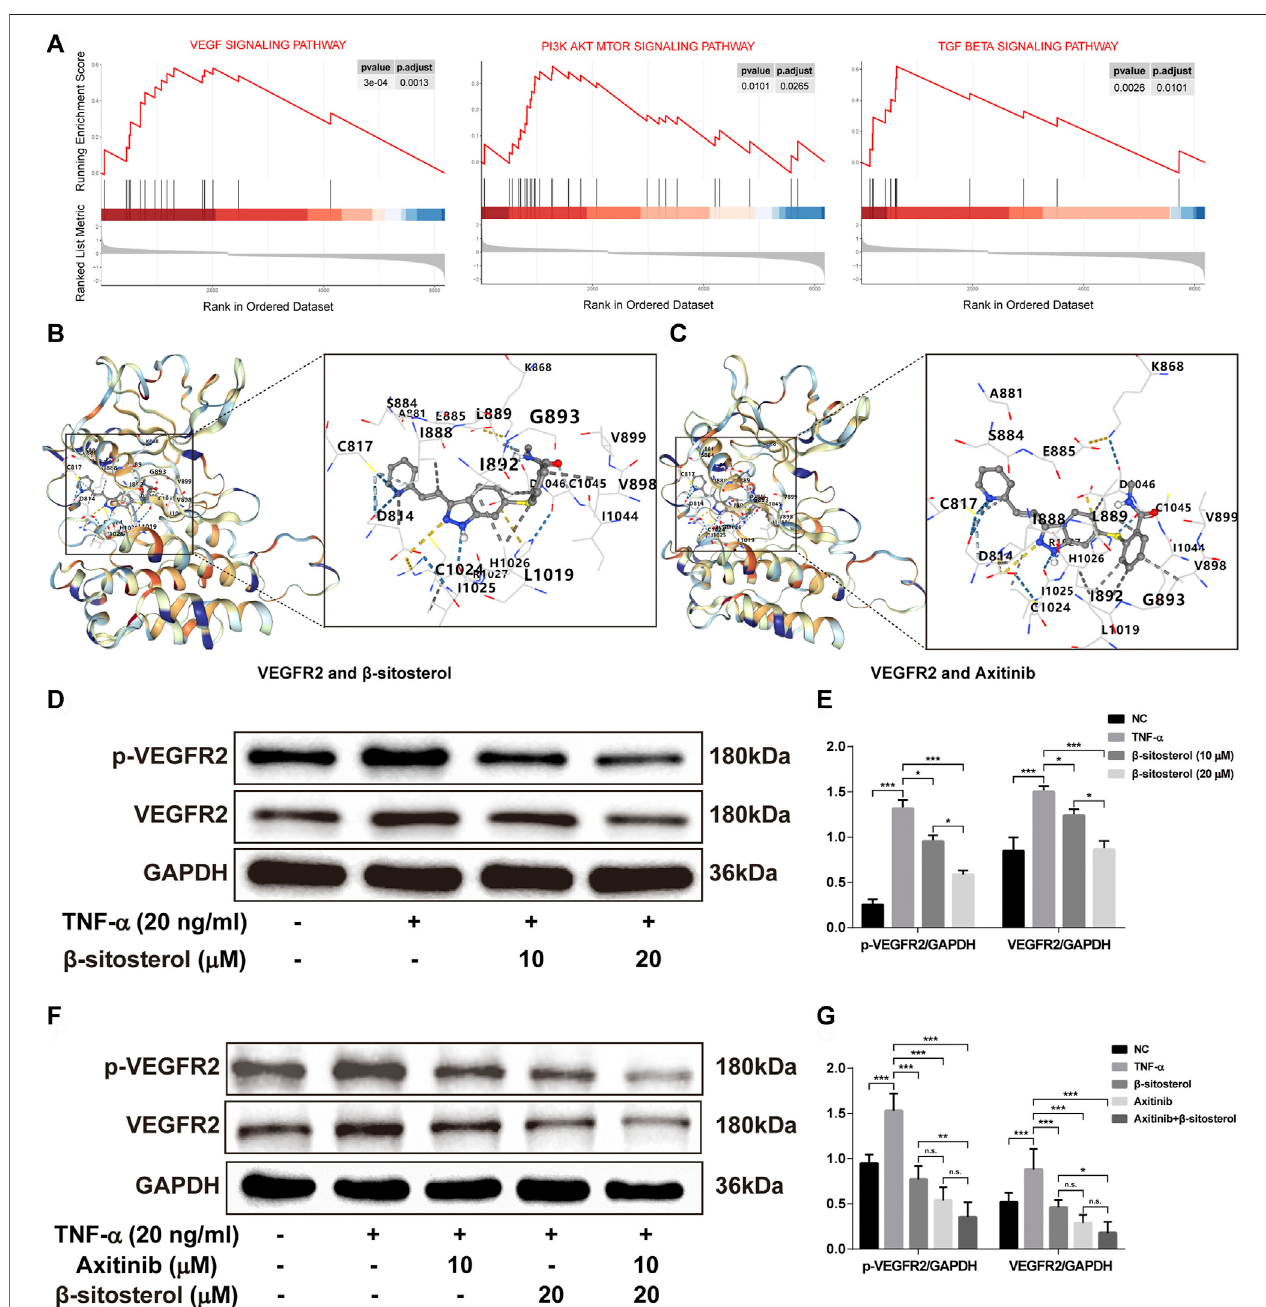
FIGURE4| Theeffect ofVEGFsignaling pathway in TNF- α -induced HUVECs regulated byBSS. (A) GSEA analysisofKEGG signaling pathway inthe GSE121894 dataset.ThestructuralinteractionsbetweenVEGFR2and BSS (B) andbetweenVEGFR2and axitinib (C) weredescribed bymolecularsimulation,andbindingaf fi nityof VEGFR2 with BSS and axitinib is shown in Table 1 . (D) p -VEGFR2 and VEGFR2 protein levels in HUVECs (on TNF- α 20 ng/ml for 1 h) intervened with BSS dosage groups were detected by immunoblotting and the relative expression levels (E) of proteins were corrected by GAPDH ( n = 3). ( F) p -VEGFR2 and VEGFR2 protein levelsinHUVECsintervenedwithBSSandaxitinib weredetectedbyimmunoblotting,andtherelativeexpressionlevels (G) ofproteinswerecorrectedbyGAPDH( n =3). All data are shown as the mean ± SEM. * p < 0.05, ** p < 0.01, *** p < 0.001, n.s. = not signi fi cant.